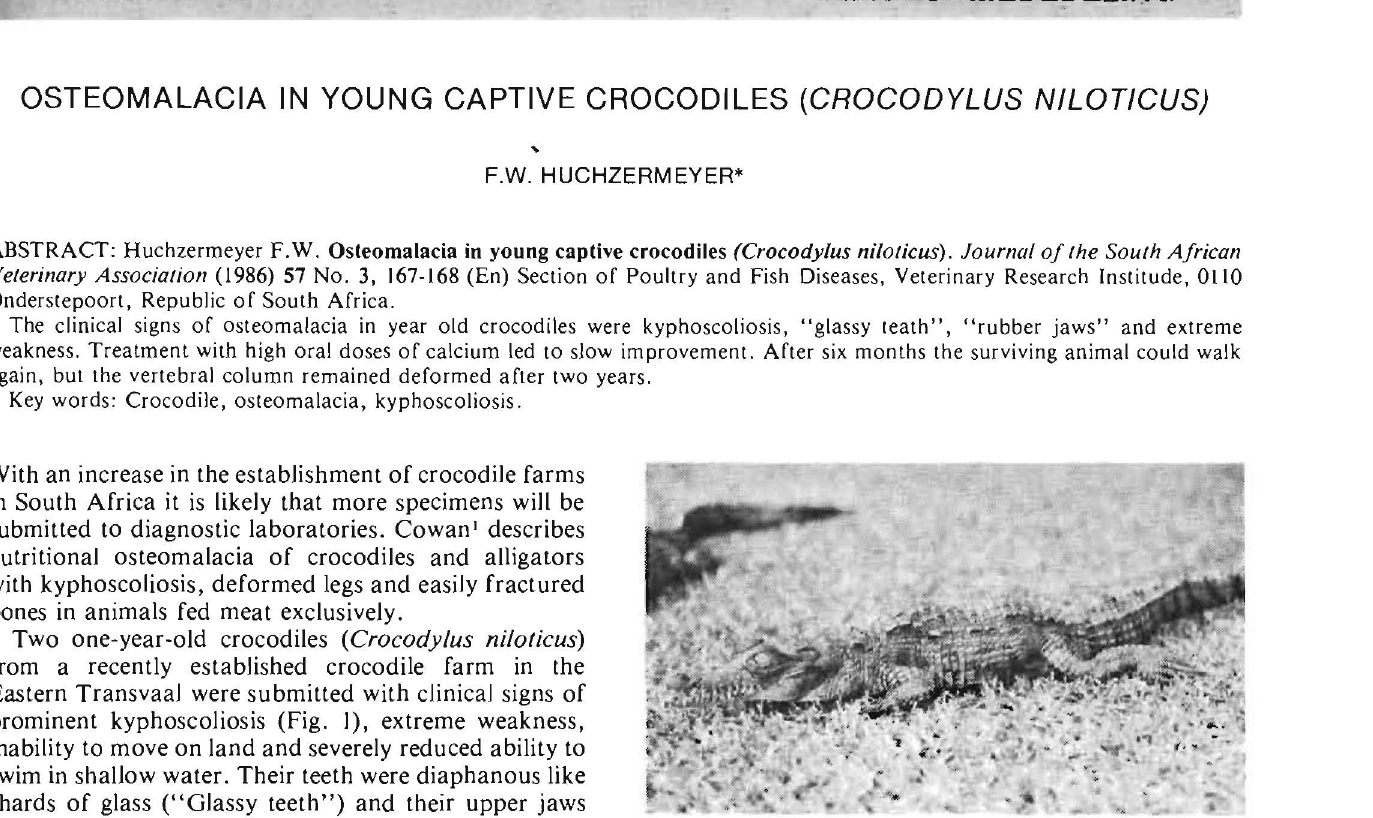
Fig. 2: "Rubber jaws" - osteomalacia in a young crocodile.